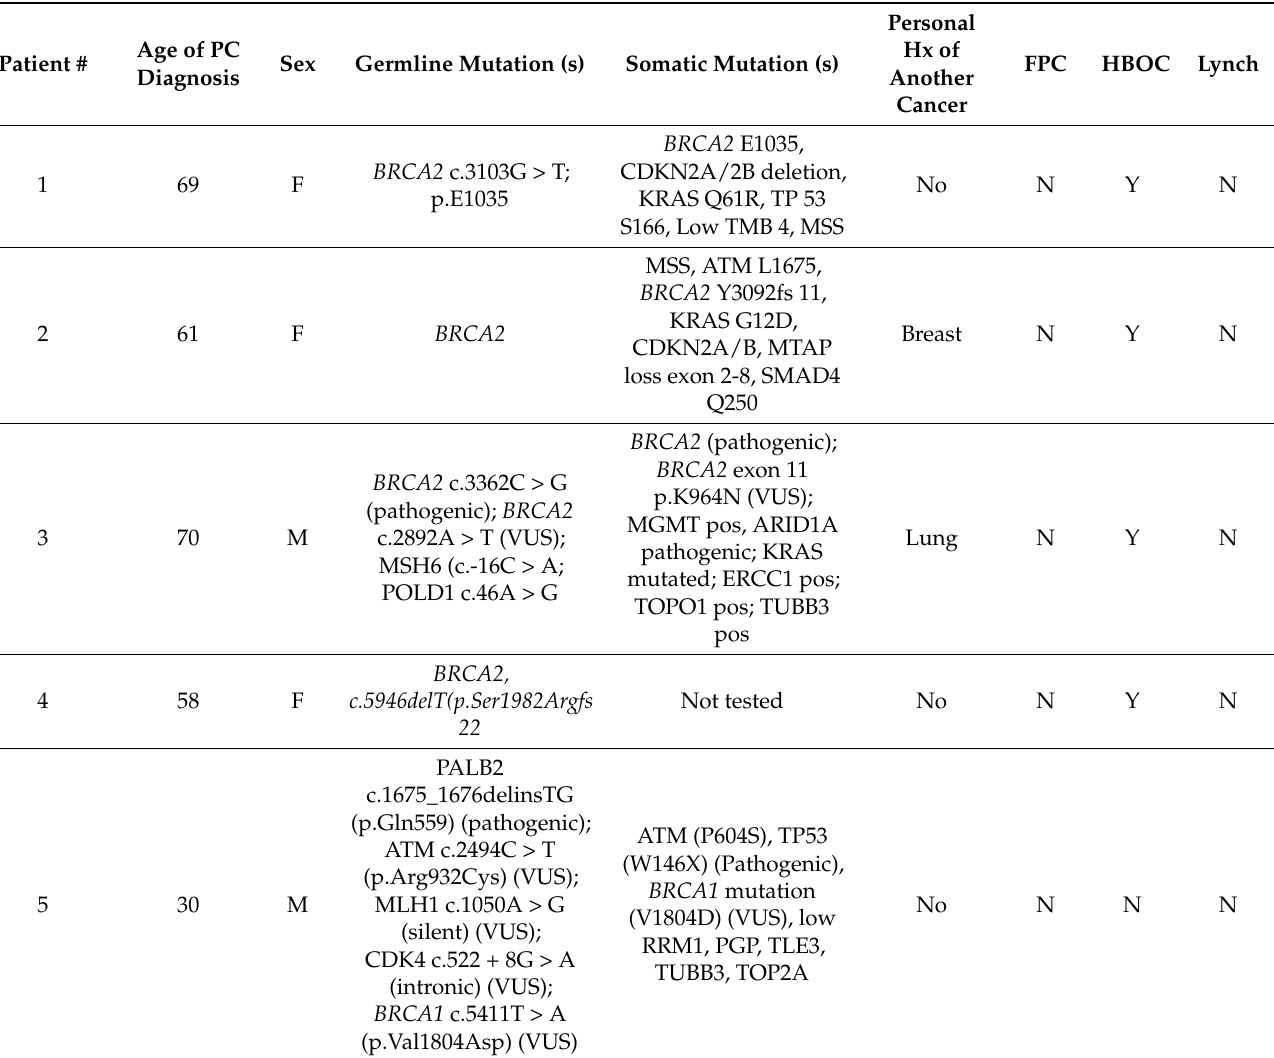
Table 2. Patient’s genetic characteristics.